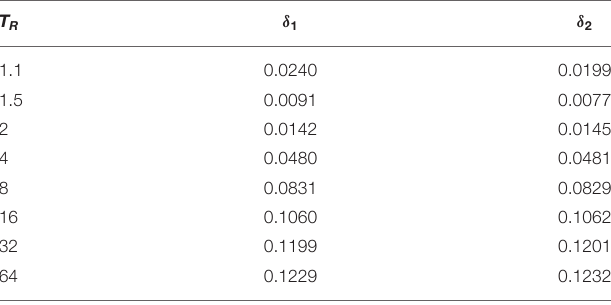
FIGURE 6 | Chains with nearest neighbors Lennard-Jones interactions. (Left) Flux for N 64, T L 1, T R 64. = = =